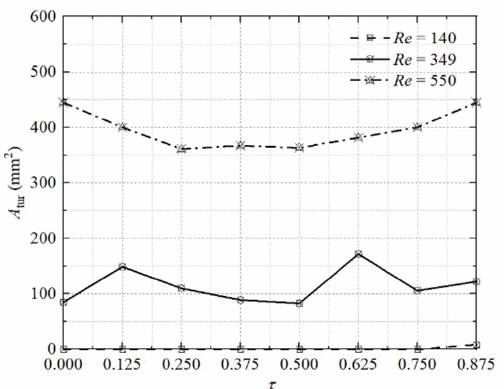
Figure 16. Influencing area of turbulence A tur, yz in different phases during one cycle at different Reynolds numbers.